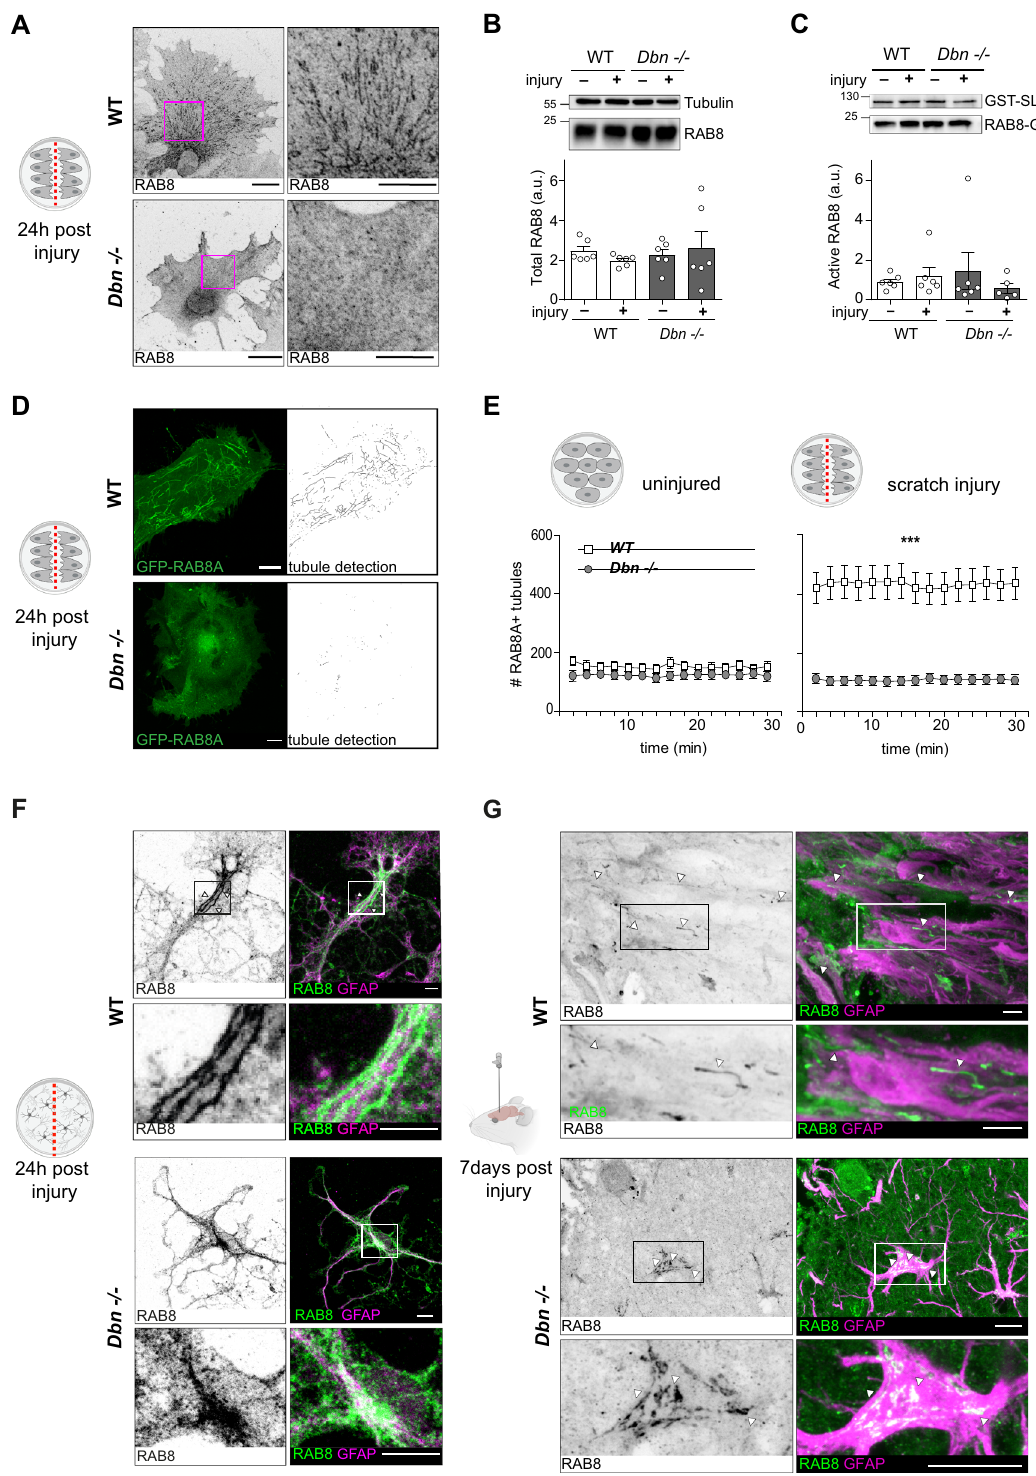
To characterize the speci fi city of endosomal traf fi cking of the DBN- dependent RAB8 compartment, we analyzed endogenous RAB8 tubules in WT and Dbn − / − astrocytes after injury using immu- nocytochemistry. RAB8-positive tubular structures were clearly orientated and extended through the cytosol of WT astrocytes, aligning closely with prominent actin fi laments (Fig. 4C). In con- trast, anti-RAB8 labeling in Dbn − / − astrocytes produced a diffuse